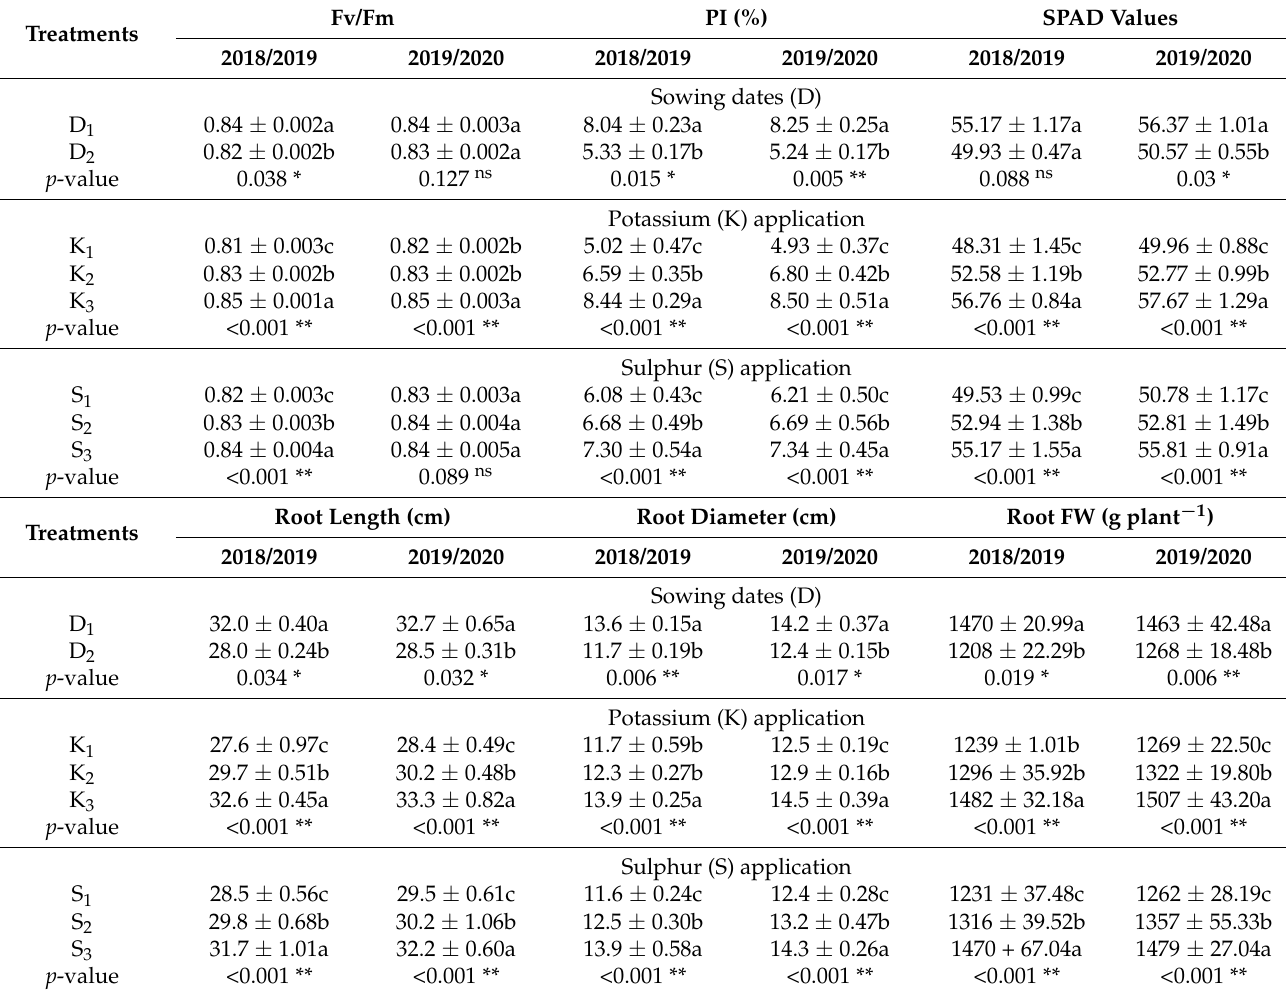
Table 3. Effect of sowing dates and applications of potassium and sulfur level and their interactions on photosynthetic efficiency (Fv/Fm, PI (%), and SPAD values), root length (cm), root diameter (cm), and root fresh weight (g plant − 1 ) of sugar beet during two growing seasons (Mean ± SE) under soil salinity (ECe = 8.96 dS m − 1 )